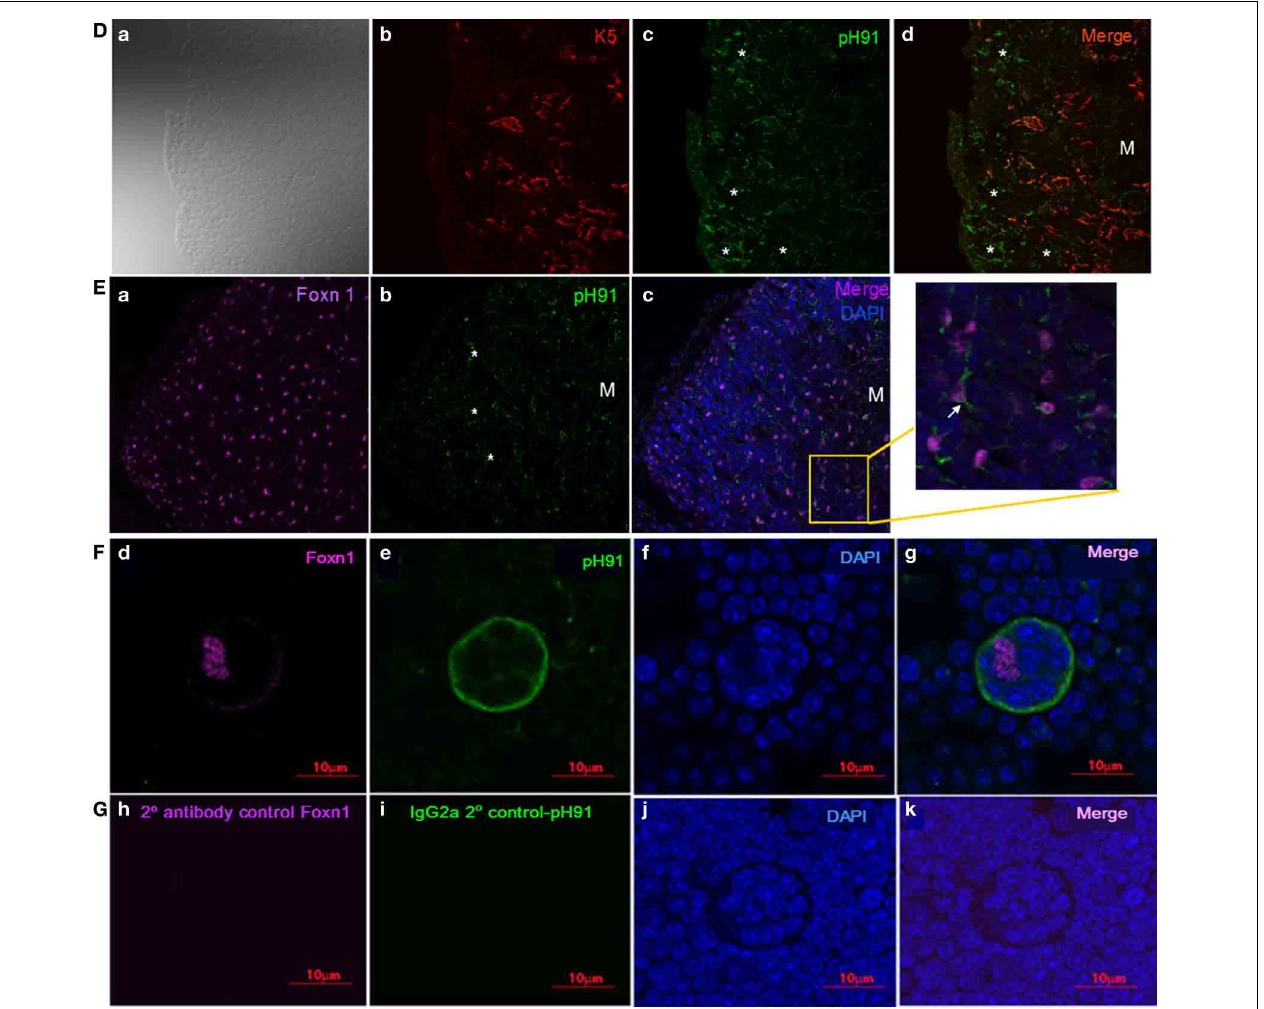
FIGURE 3 | Expression of Foxn1 and the pH91-antigen in embryonic sections. Thymic section at embryonic stage E13.5 (A) , E16.5 (B) , and E18.5 (C) were stained with anti-Foxn1 antibody (magenta) and pH91mAb (green). The merged images and insets ( A–C) , E13.5; E16.5; and E18.5 show an association of pH91 + cells with Foxn1 + cells. Magnification 20 × . (D) shows thymic section co-stained with K5 (red) and pH91 (green), The asterisks highlight pH91 + cells within the thymic cortex. M indicates the location of the medulla. Magnification 40 × . (Ea–c) shows the expression of Foxn1 and pH91 in thymic tissue section 2 weeks after birth. Sections were stained with